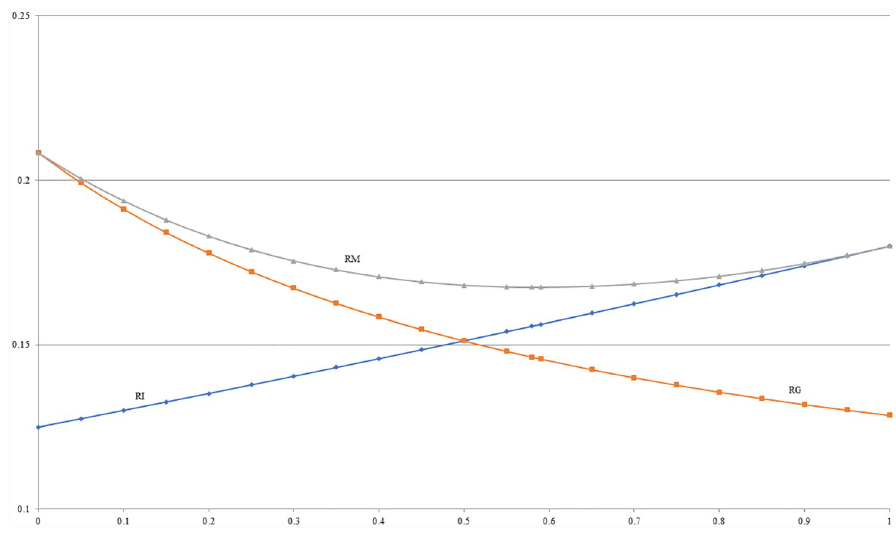
Fig 11. A comparison of revenues between IB, GB and MIX with respect to m